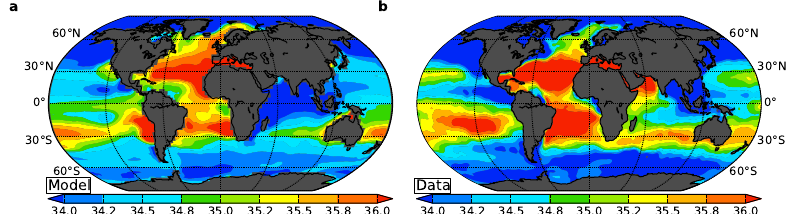
Figure 5. Salinity distribution (psu) at the ocean surface. Data from the World Ocean Atlas 2009 (Antonov et al., 2010).